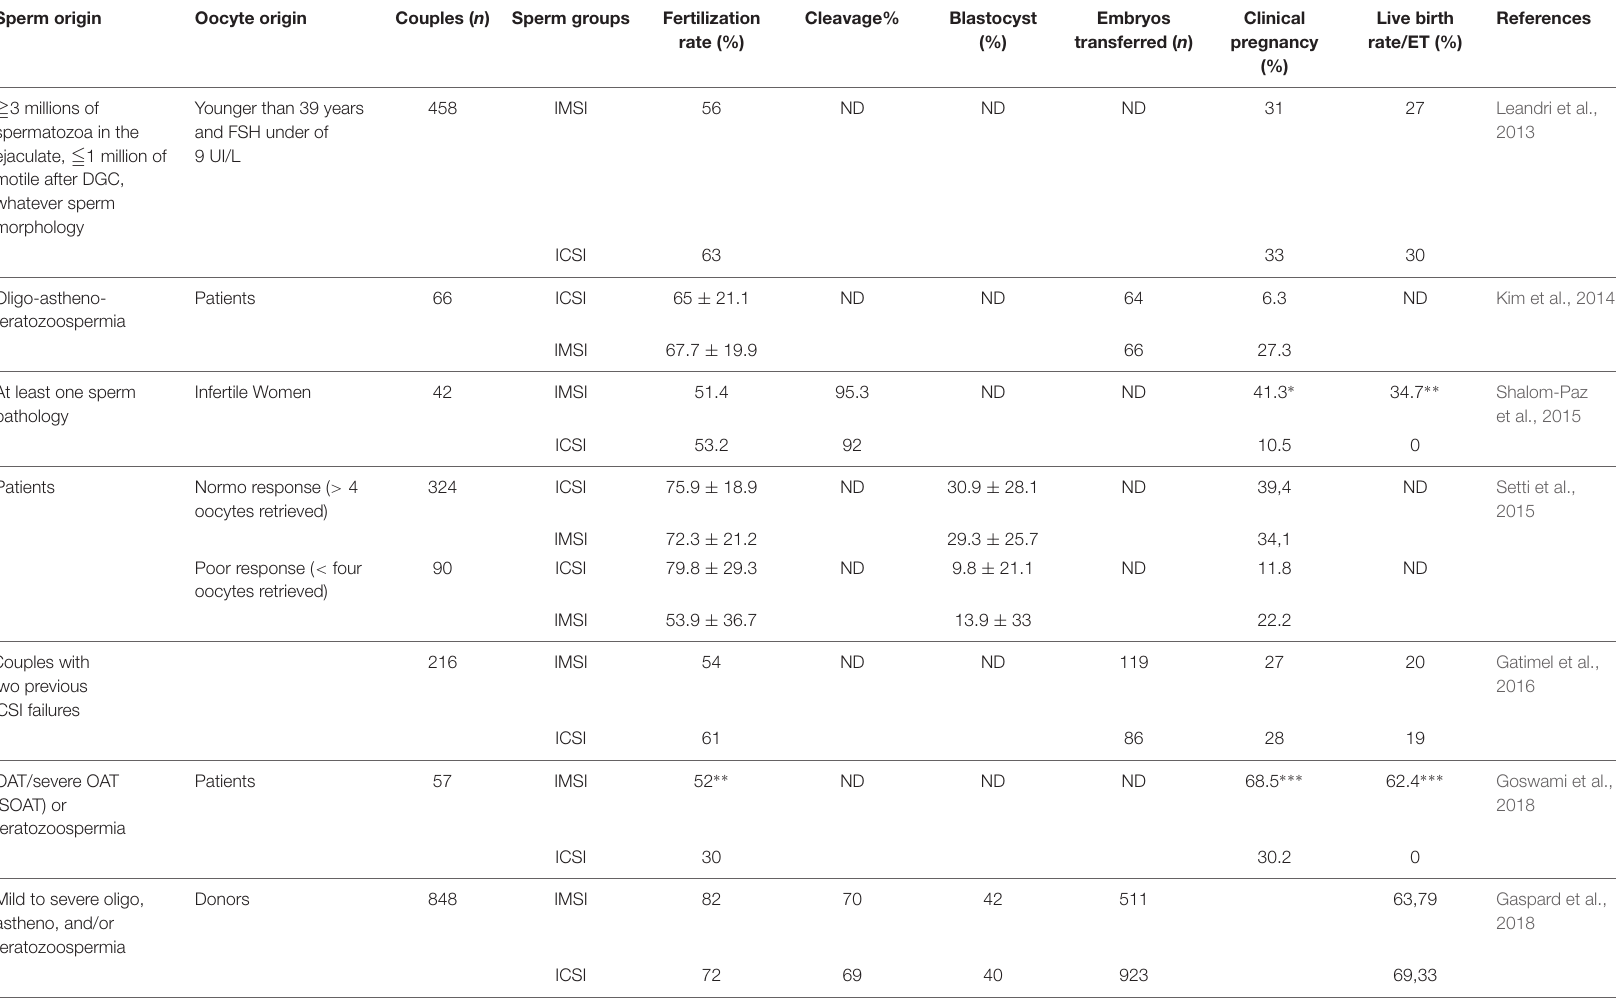
TABLE 7 | Reproductive outcomes of ARTs spermatozoa selected by